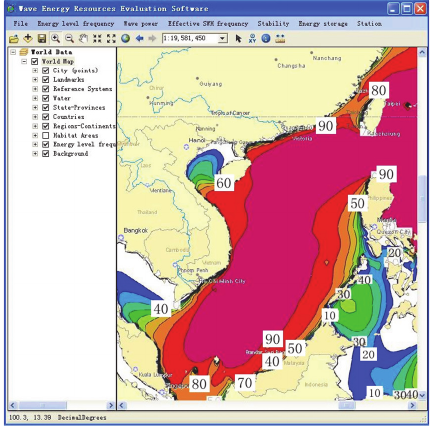
Figure 5: The 𝐶 V of wave power density in the South China Sea (percentage %).